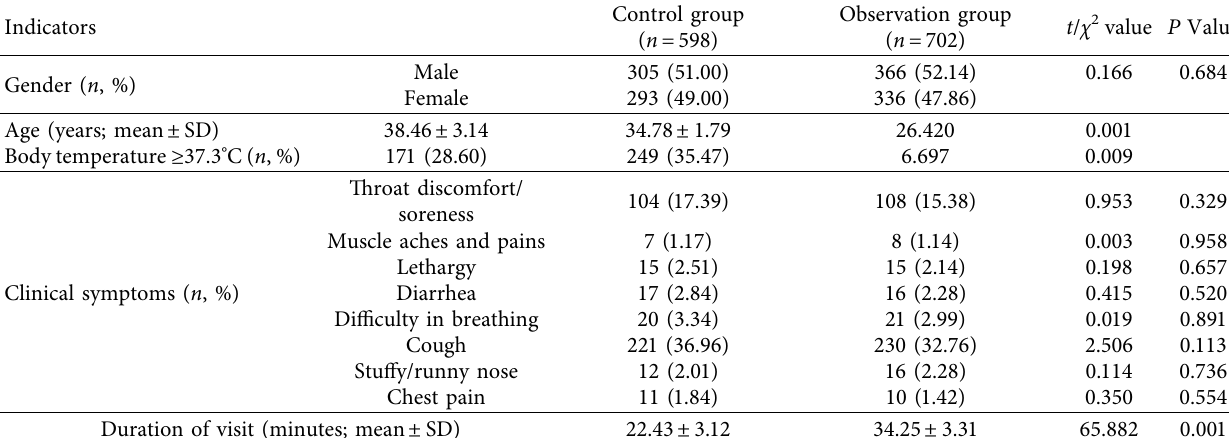
Table 1: Analysis of the results of basic patient